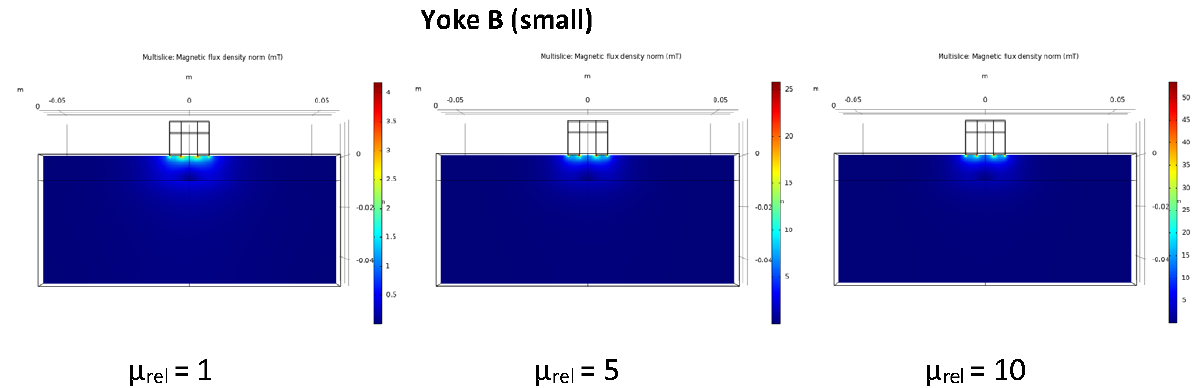
Figure 7. Distribution of the calculated flux density in the cladded block for three values of relative permeability of the cladding if the small magnetizing yoke (Yoke B) is applied.